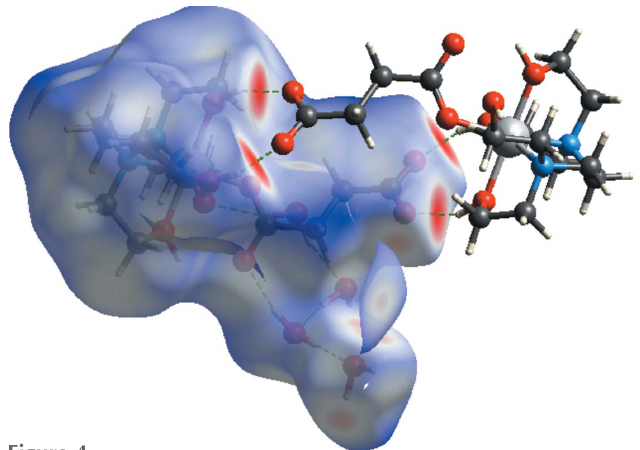
Figure 4 Hirshfeld surface mapped over d norm to visualize the intermolecular interactions.